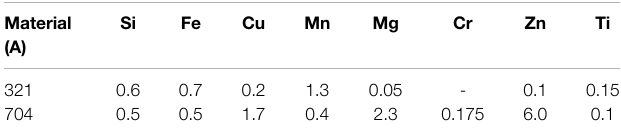
TABLE 1 | Chemical compositions of the aluminum alloys (wt